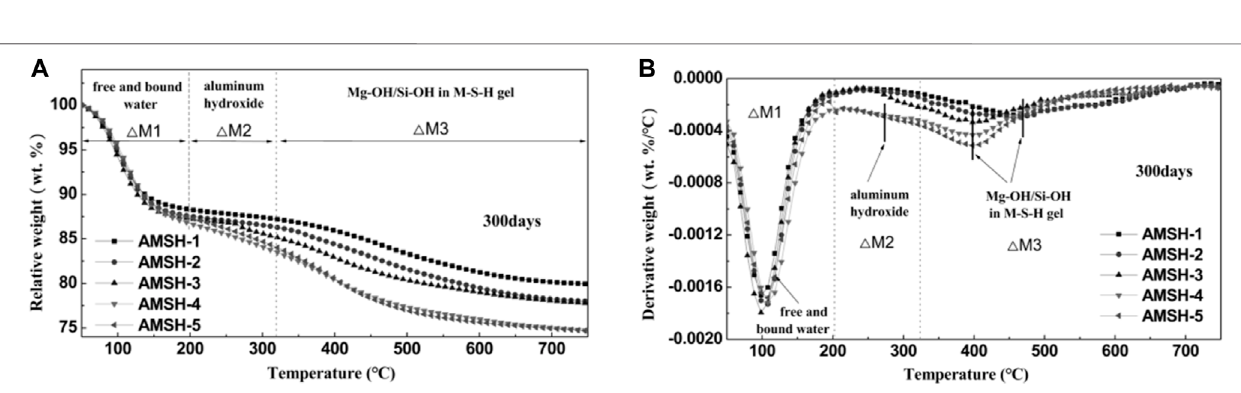
FIGURE 2 | (A) Thermo-gravimetric (TG) and (B) Derivative thermo-gravimetric (DTG) data for MSH samples with different Al 3+ contents after curing for 300 days.